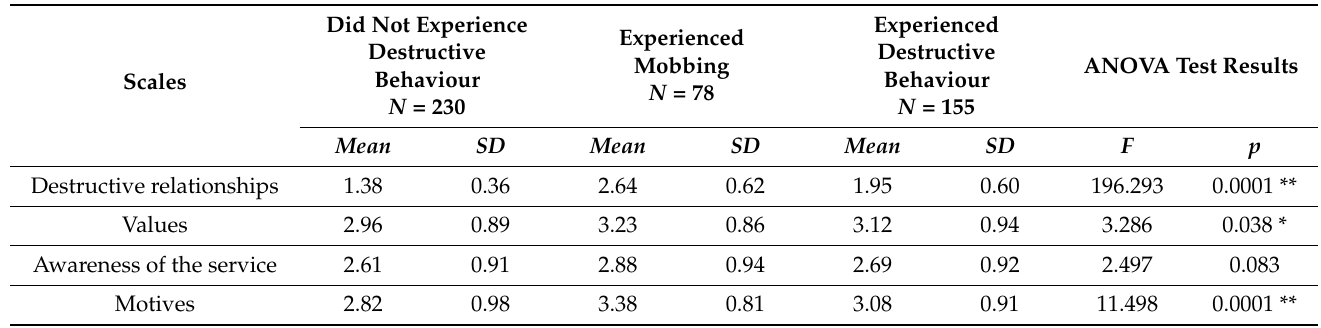
Table 3. The ANOVA test at the scale level by the nature of experience.